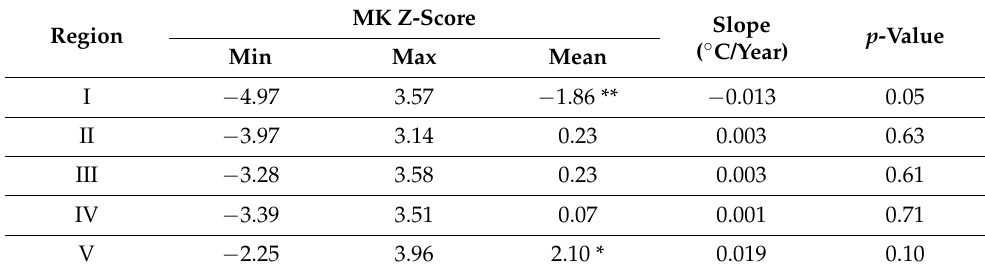
Table 2. MK trend test ( Z ) statistics, Sen’s slope, and p value for the LST trends analysis.